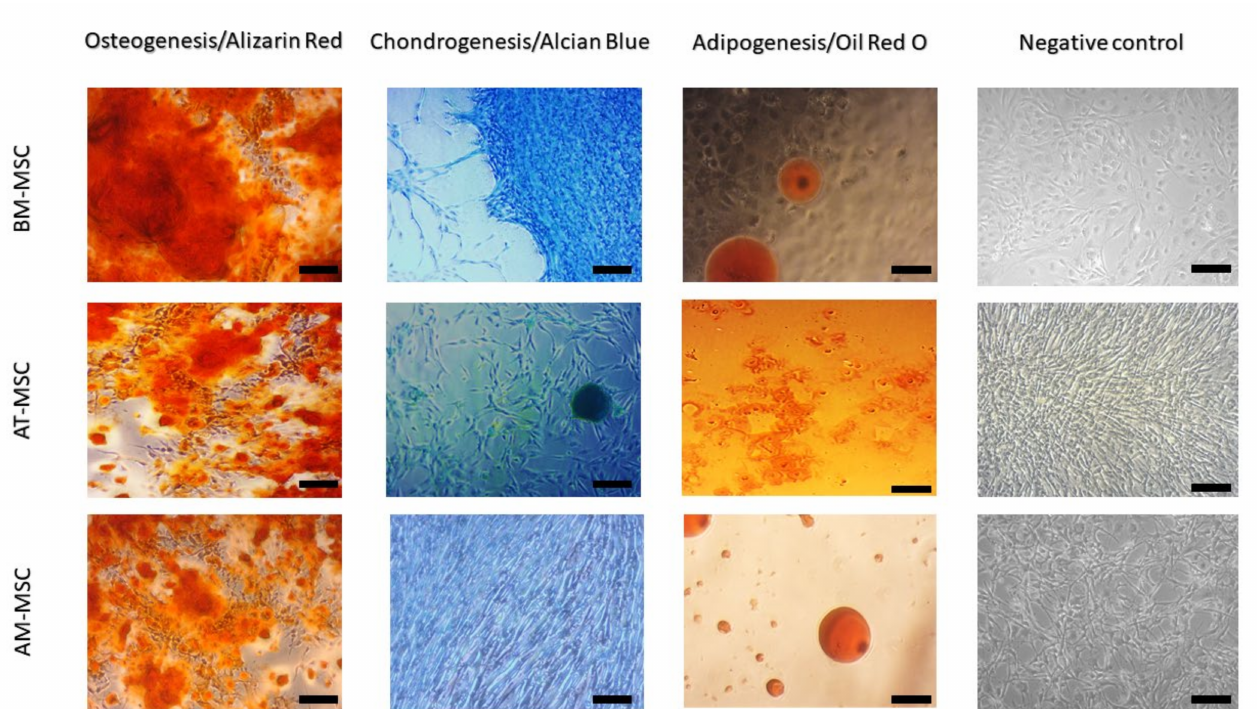
Figure 5. Multilineage potential of canine MSCs. All types of canine MSCs showed high osteogenic (presence of calcium deposits detected by Alizarin red) and chondrogenic potential (presence of glycoproteoglycanes detected by Alcian blue staining); however, there was the absence (BM-MSCs and AM-MSCs) or low (AT-MSCs) level of the adipogenic potential (triglycerides detected by Oil Red O staining). Scale bars = 50 µ